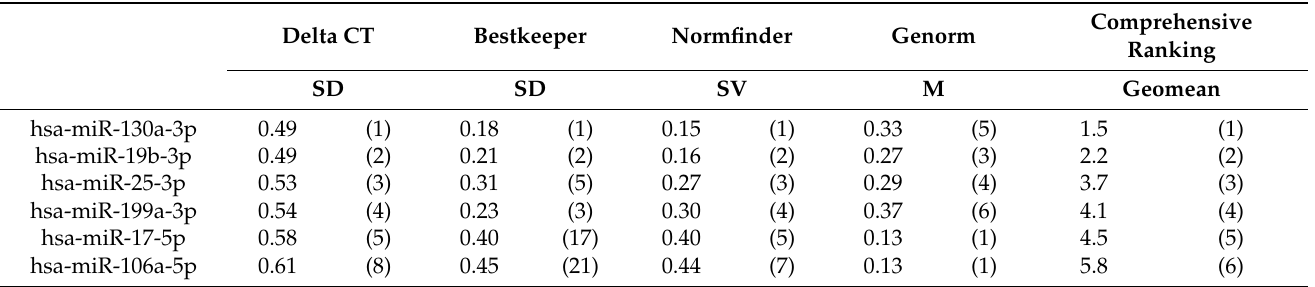
Table 4. Top 6 positions in the RG ranking of the stable first-quartile EV-miRNAs ordered following comprehensive ranking. Bestkeeper Normfinder Genorm